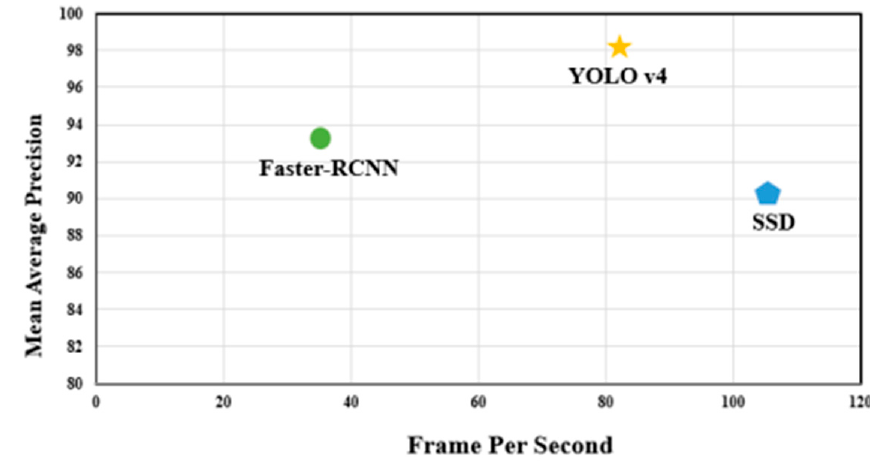
Figure 6. Comparison of performance of Deep learning Models.